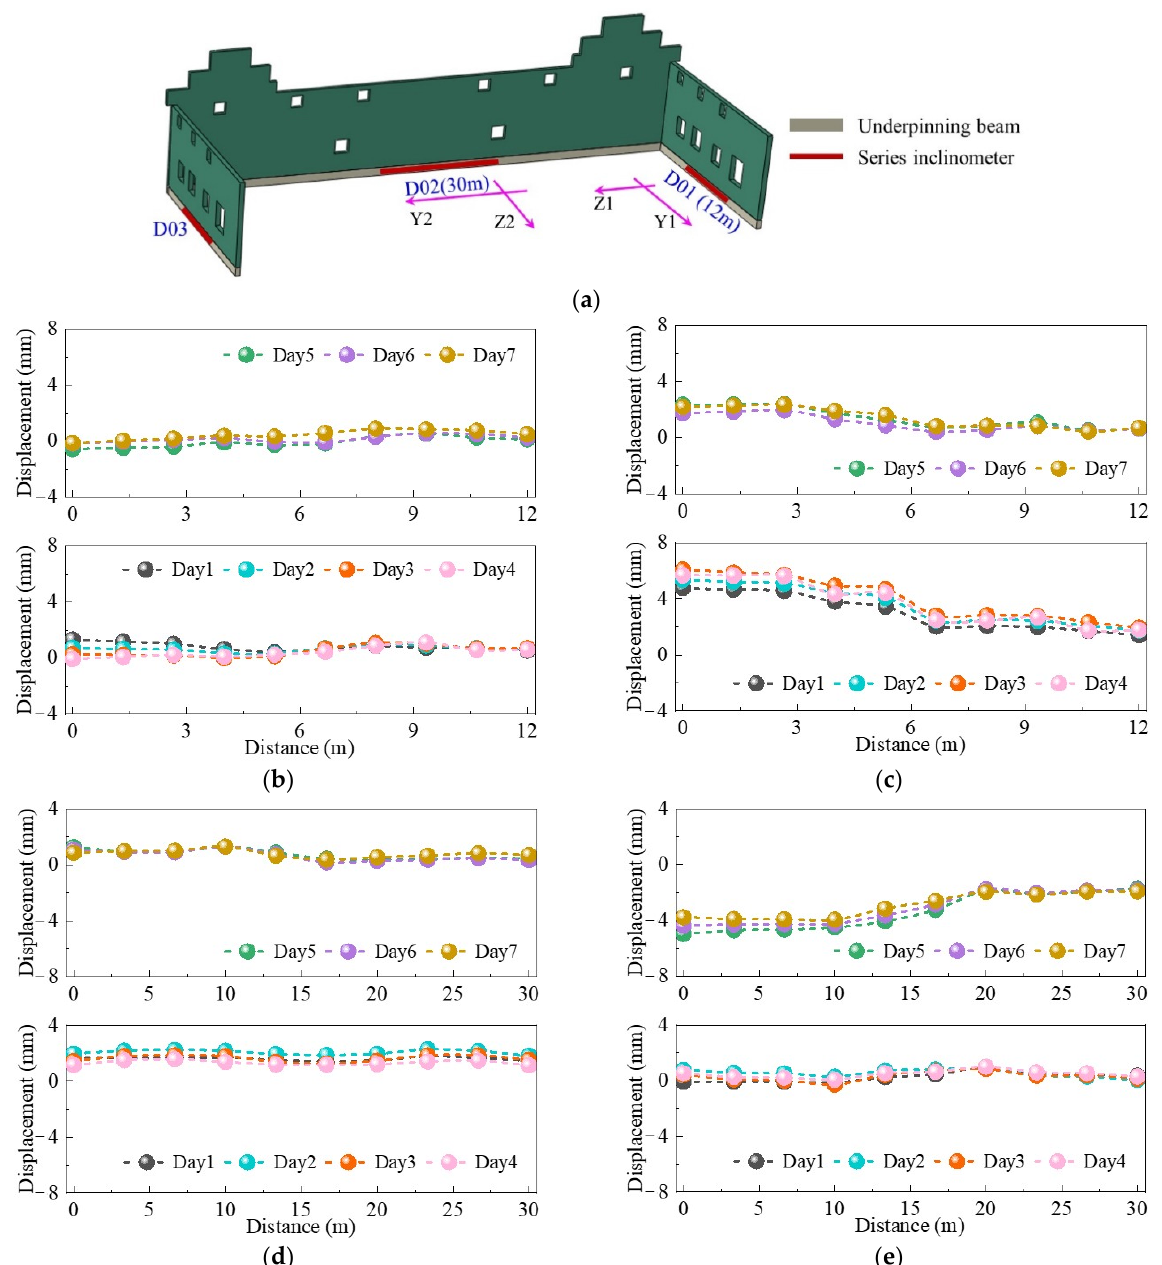
Figure 9. ( a ) The distribution of the serious inclinometers; the displacements measured by: D01 along the ( b ) Y 1 and ( c ) Z 1 directions and D02 along the ( d ) Y 2 and ( e ) Z 2 directions.